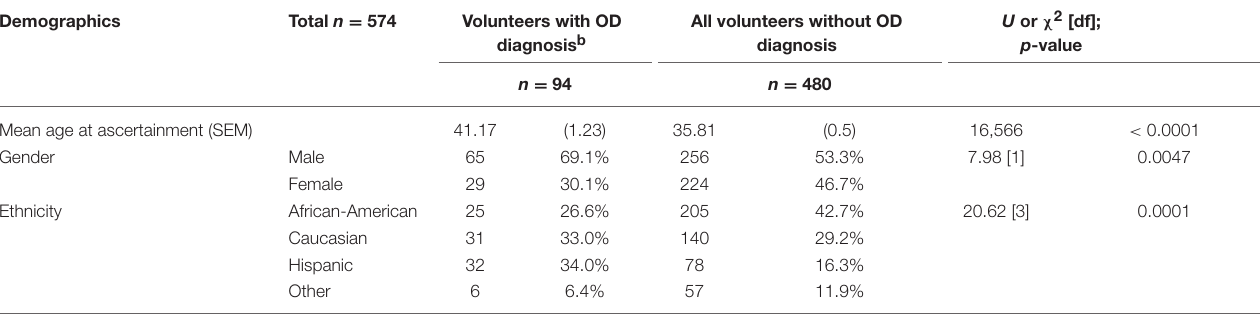
(B) Comparison of volunteers with OD diagnosis vs. all volunteers without OD (i.e., combining volunteers with drug diagnoses except OD, and normal volunteers). Demographics